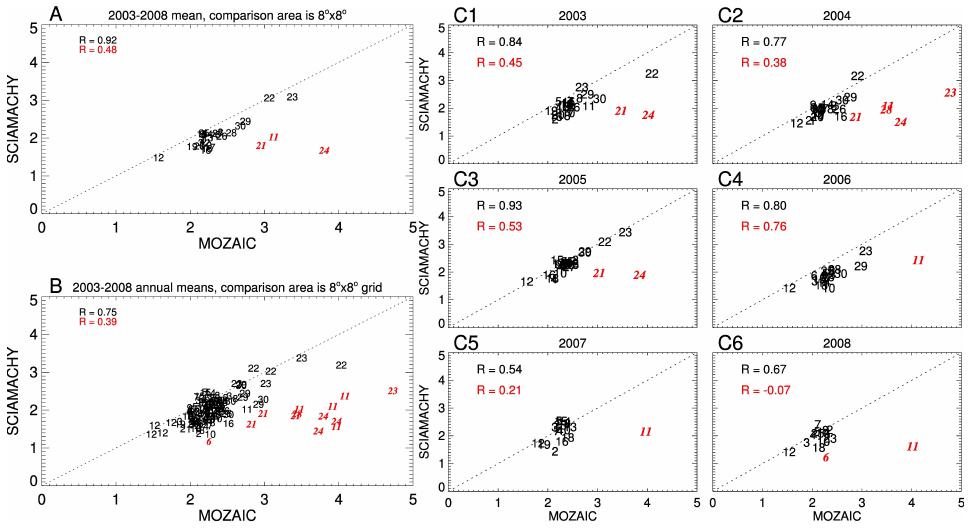
Fig. 4. (A) Scatter plot of SCIAMACHY and MOZAIC 2003–2008 mean CO total columns for the locations shown in Figs. 2 and 3. Stations are numbered according to Fig. 2 and Table 1. Red colored numbers indicate locations where the absolute differences between SCIAMACHY and MOZAIC are larger than 1 × 10 18 moleculescm − 2 . The correlation values correspond to the correlation for all locations (red value) and correlation with locations where absolute differences between SCIAMACHY and MOZAIC is larger than 1 × 10 18 moleculescm − 2 removed (black value). (B) Similar to (A) but for all annual means for the period 2003–2008. (C1–C6) Similar to (B) but for every year separately.